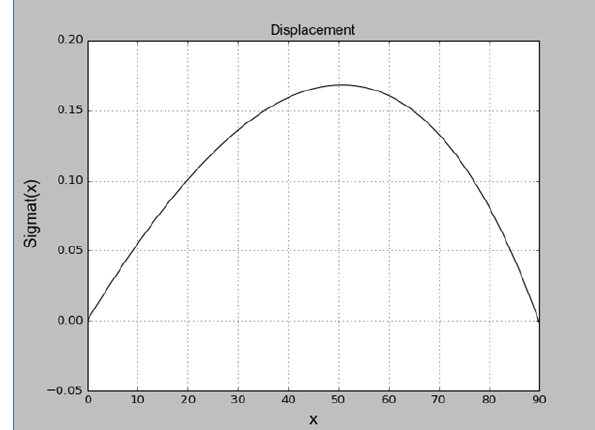
Figure 5: The distribution law of displacement of cross-sections of the